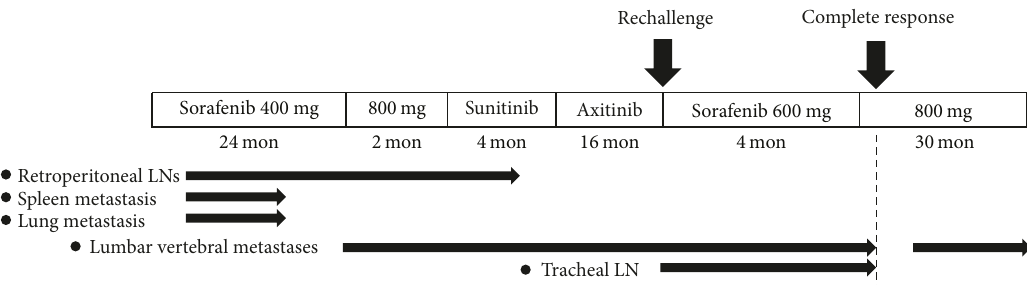
Figure 1: Sequence of events for initiation of molecular targeted therapy and for appearance of metastatic lesions.